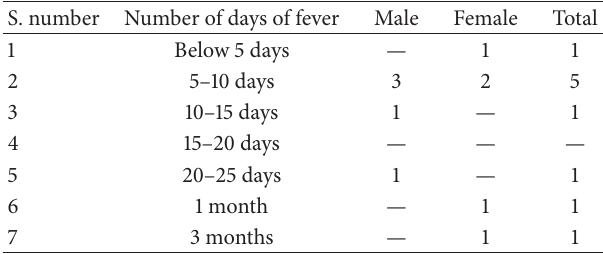
Table 4: Duration of leptospiral fever among the positive cases.